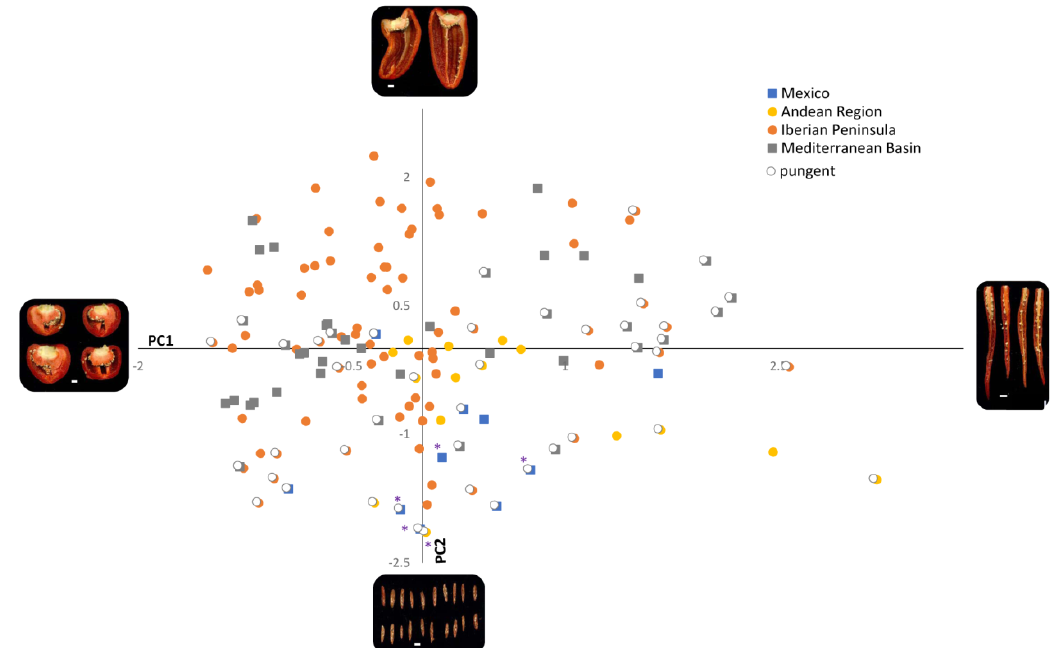
Figure 5. Scatter plot for the PCA analysis performed on the whole collection. Pungent peppers are highlighted with a white circle. Purple asterisks indicate C. annuum var. glabriusculum accessions. Pictures represent the accessions at the outermost edges of each component. White lines inside the photos indicate a 1 cm scale.